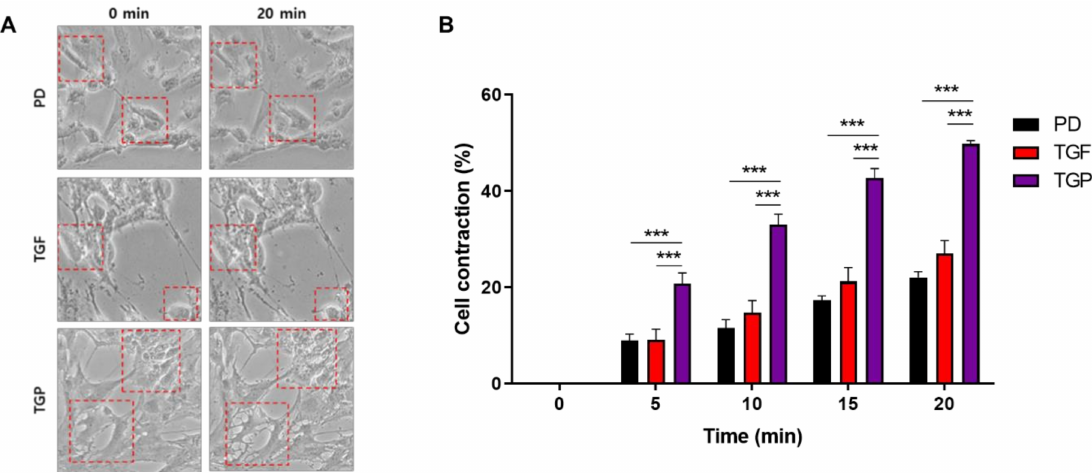
Figure 6. Contractile strength of the differentiated SMCs from hUDSCs. ( A ) Morphology of contractile SMCs. The cells were treated with carbachol to induce contraction, and images were obtained at 0 and 20 min after induction. ( B ) Percentage of carbachol-induced contracting cells. Data are presented as mean ± SEM, n = 6: PD; PD98059, TGF; TGF- β 1, TGP; PD98059 and TGF- β 1. *** p < 0.005 vs. PD or TGF